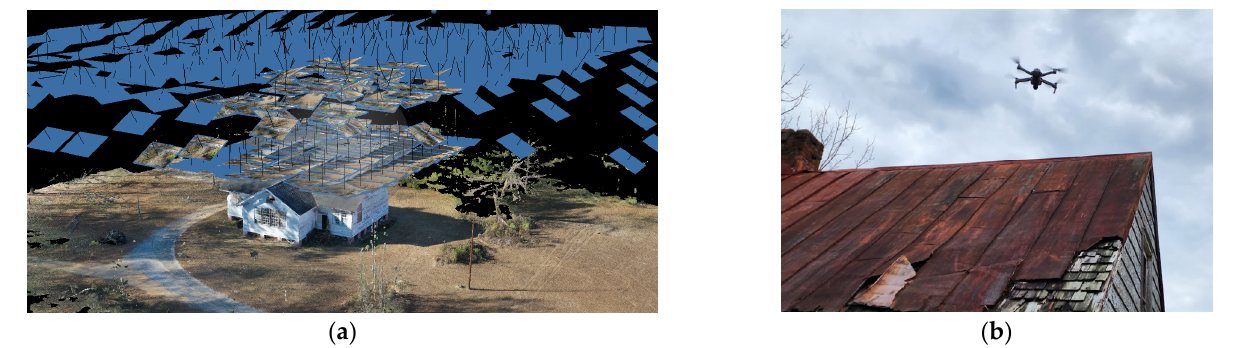
Figure 2. UAV photogrammetry: ( a ) UAV photogrammetry schematic; ( b ) a Mavic Pro 2 UAV [41] is being used to survey a historic structure.